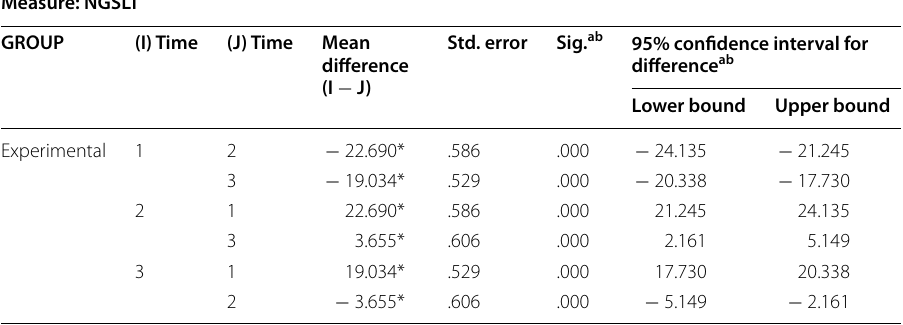
Based on estimated marginal means *The mean difference is significant at the .05 level a Adjustment for multiple comparisons: Bonferroni